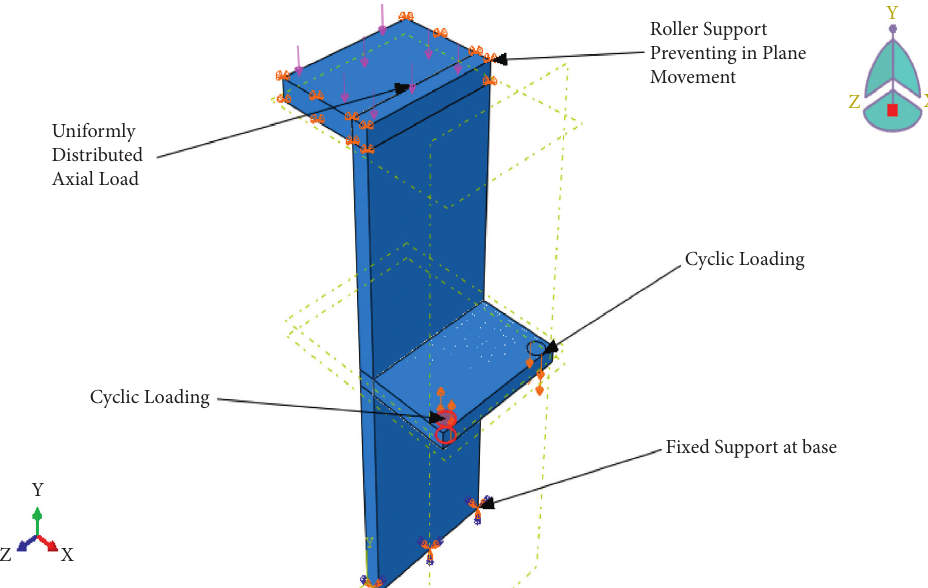
Figure 6: Boundary and loading condition of the models.